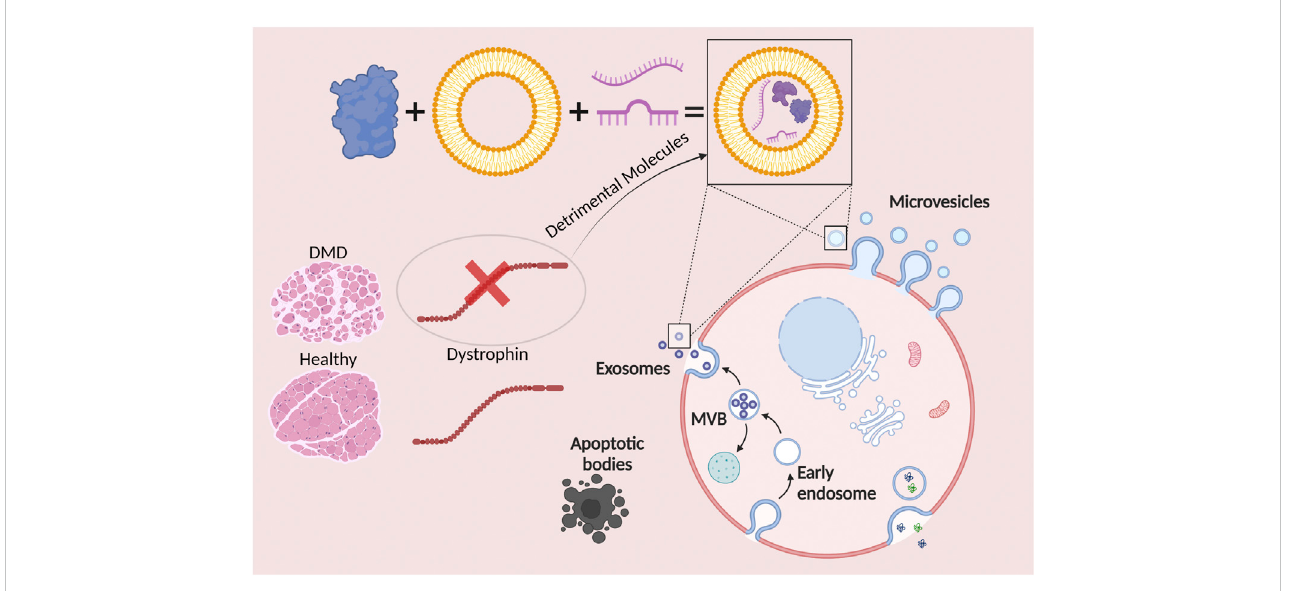
FIGURE 1 Extracellular vesicles (EVs) are hailed as potential modulators of Duchenne muscular dystrophy progression. EVs are represented by exosomes, microvesicles, and apoptotic bodies. The cargo of exosomes and microvesicles consists of effector molecules such as proteins, lipids, and nucleic acids. The lack of a functional dystrophin leads to the formation and release of exosomes and microvesicles with detrimental molecules, inducing both negative paracrine and endocrine